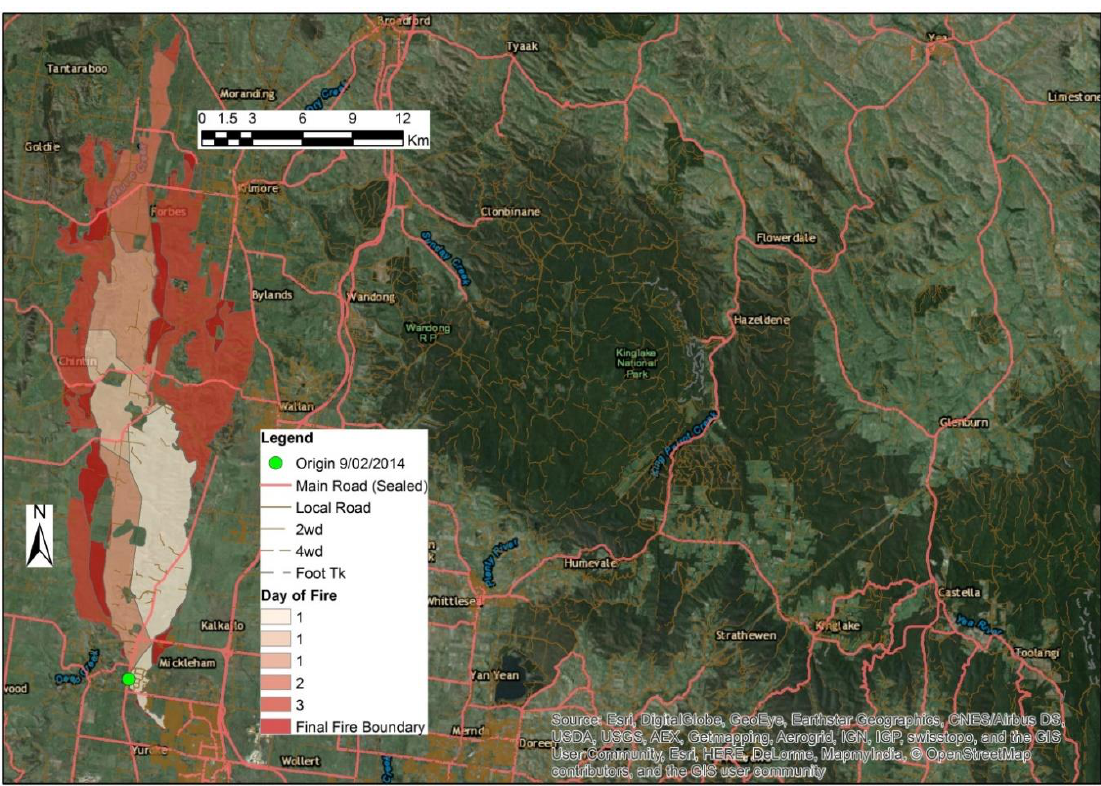
Figure A9. Mickleham fire progression map.